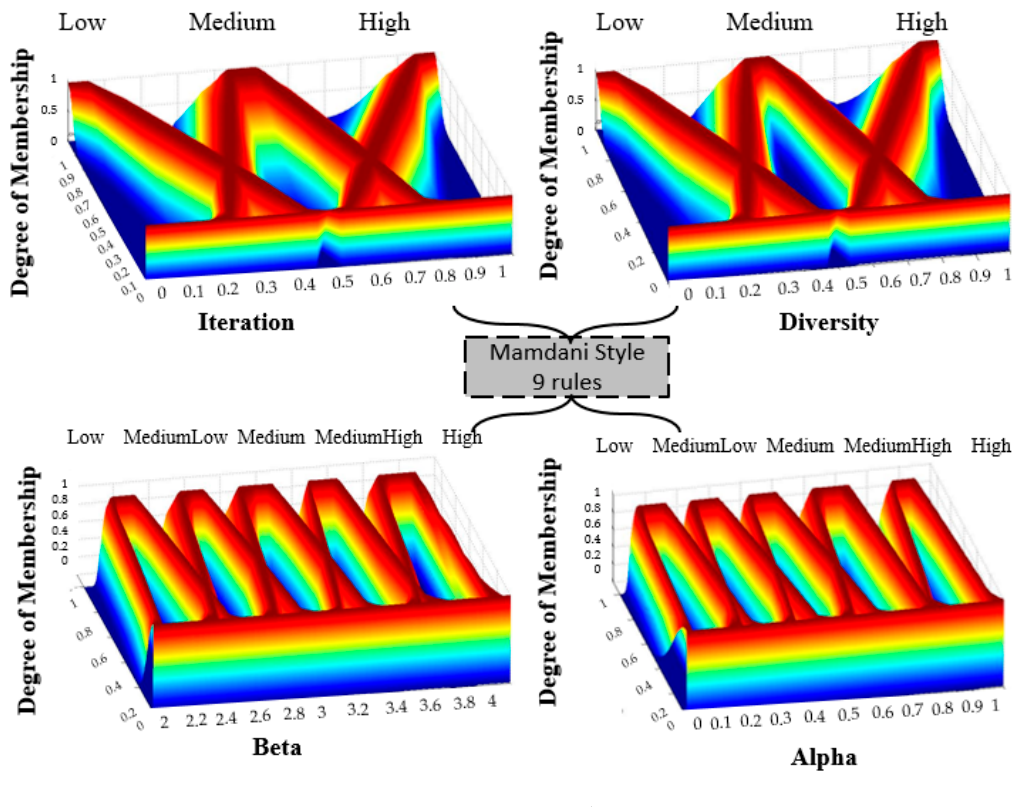
Figure 13. Fuzzy BCO with GT2FLS. Table 3. Rules for the Fuzzy BCO with dynamic adaptation of the beta and alpha parameter